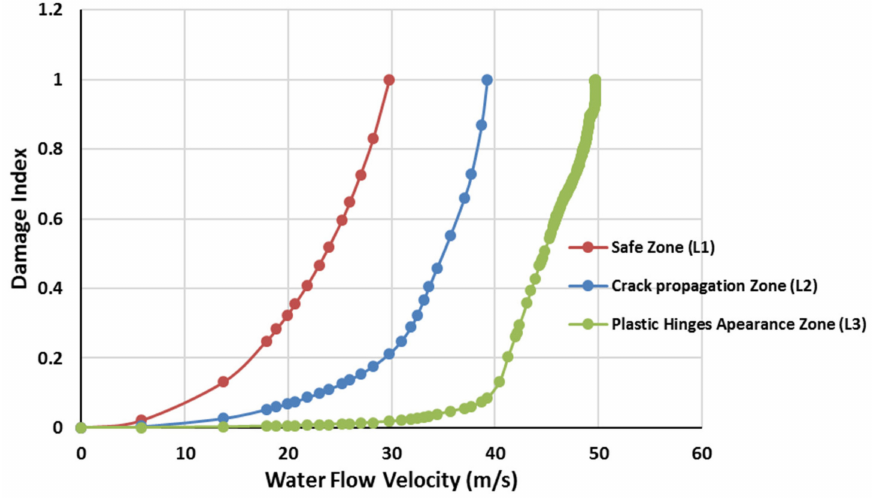
Figure 14. Damage index changes for numerous damage levels of water flow